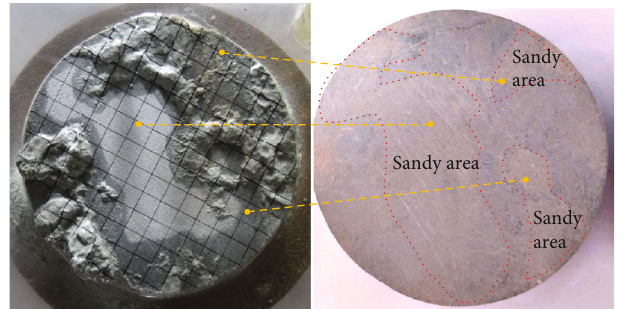
Figure 24: Uneven expansion on the surface of 6#